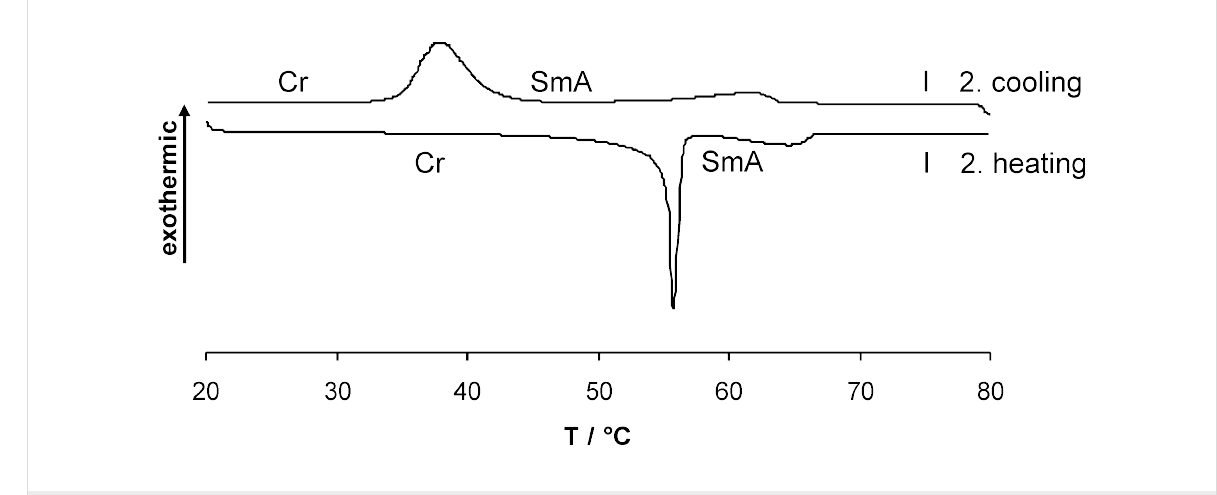
Figure 3: DSC curve of compound 4e (heating/cooling rate 5 K/min).